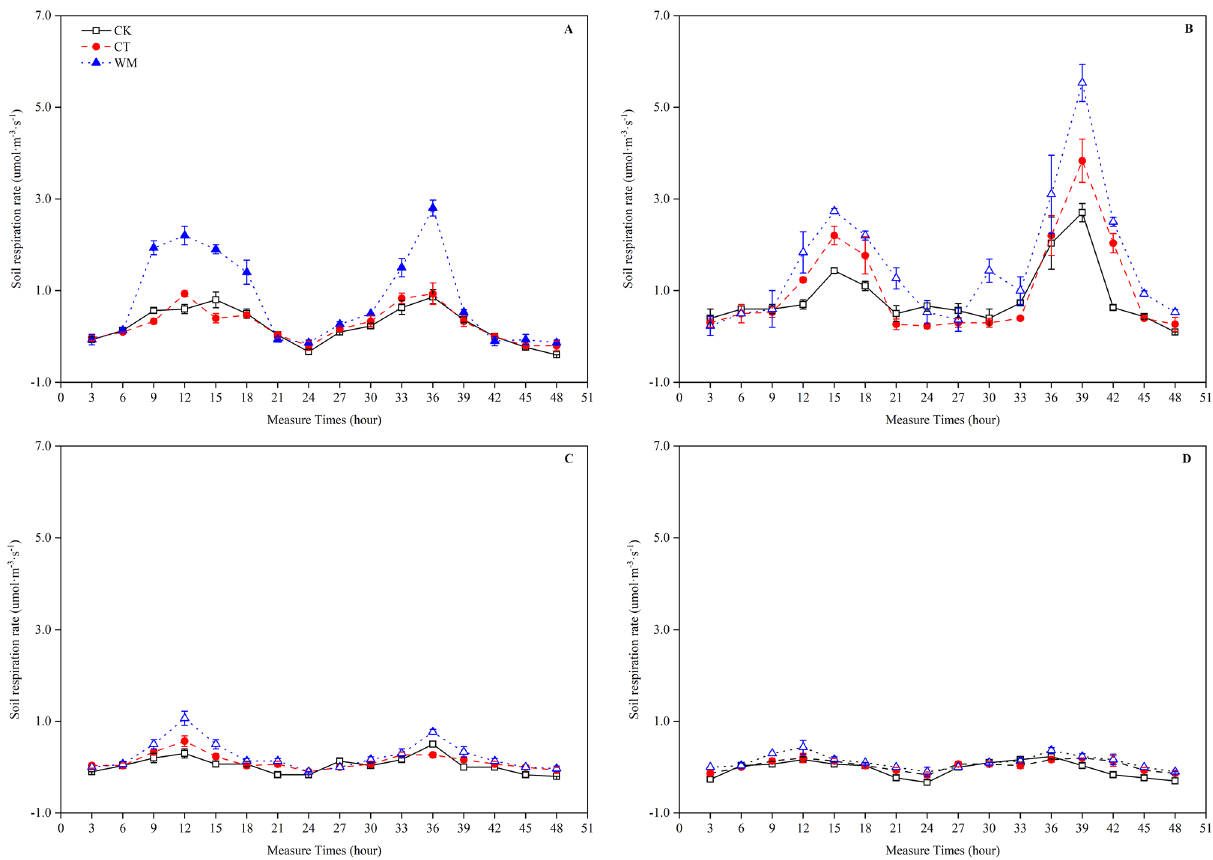
Figure 2. Diurnal dynamics of soil respiration in April ( A ), August ( B ), October ( C ) and December ( D ) of 2017. CK, natural coastal wetland; CT, cotton mono-cropping farmland; WM, wheat–maize rotation farmland. Vertical bars represent ± SD of the mean (n =